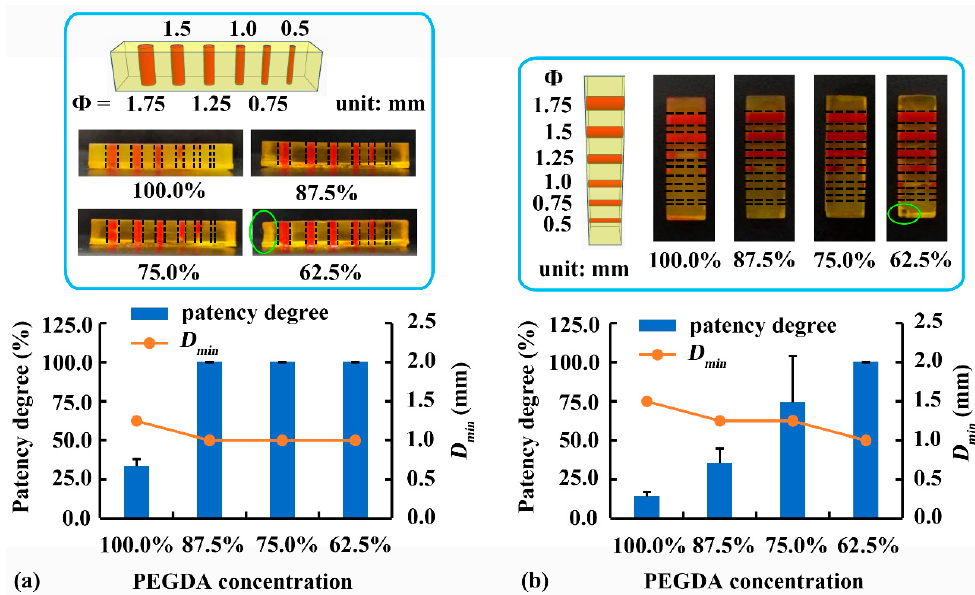
Figure 6. E ff ect of PEGDA concentration on the printability of ( a ) vertical and ( b ) horizontal channels. D min : minimum printable diameter.